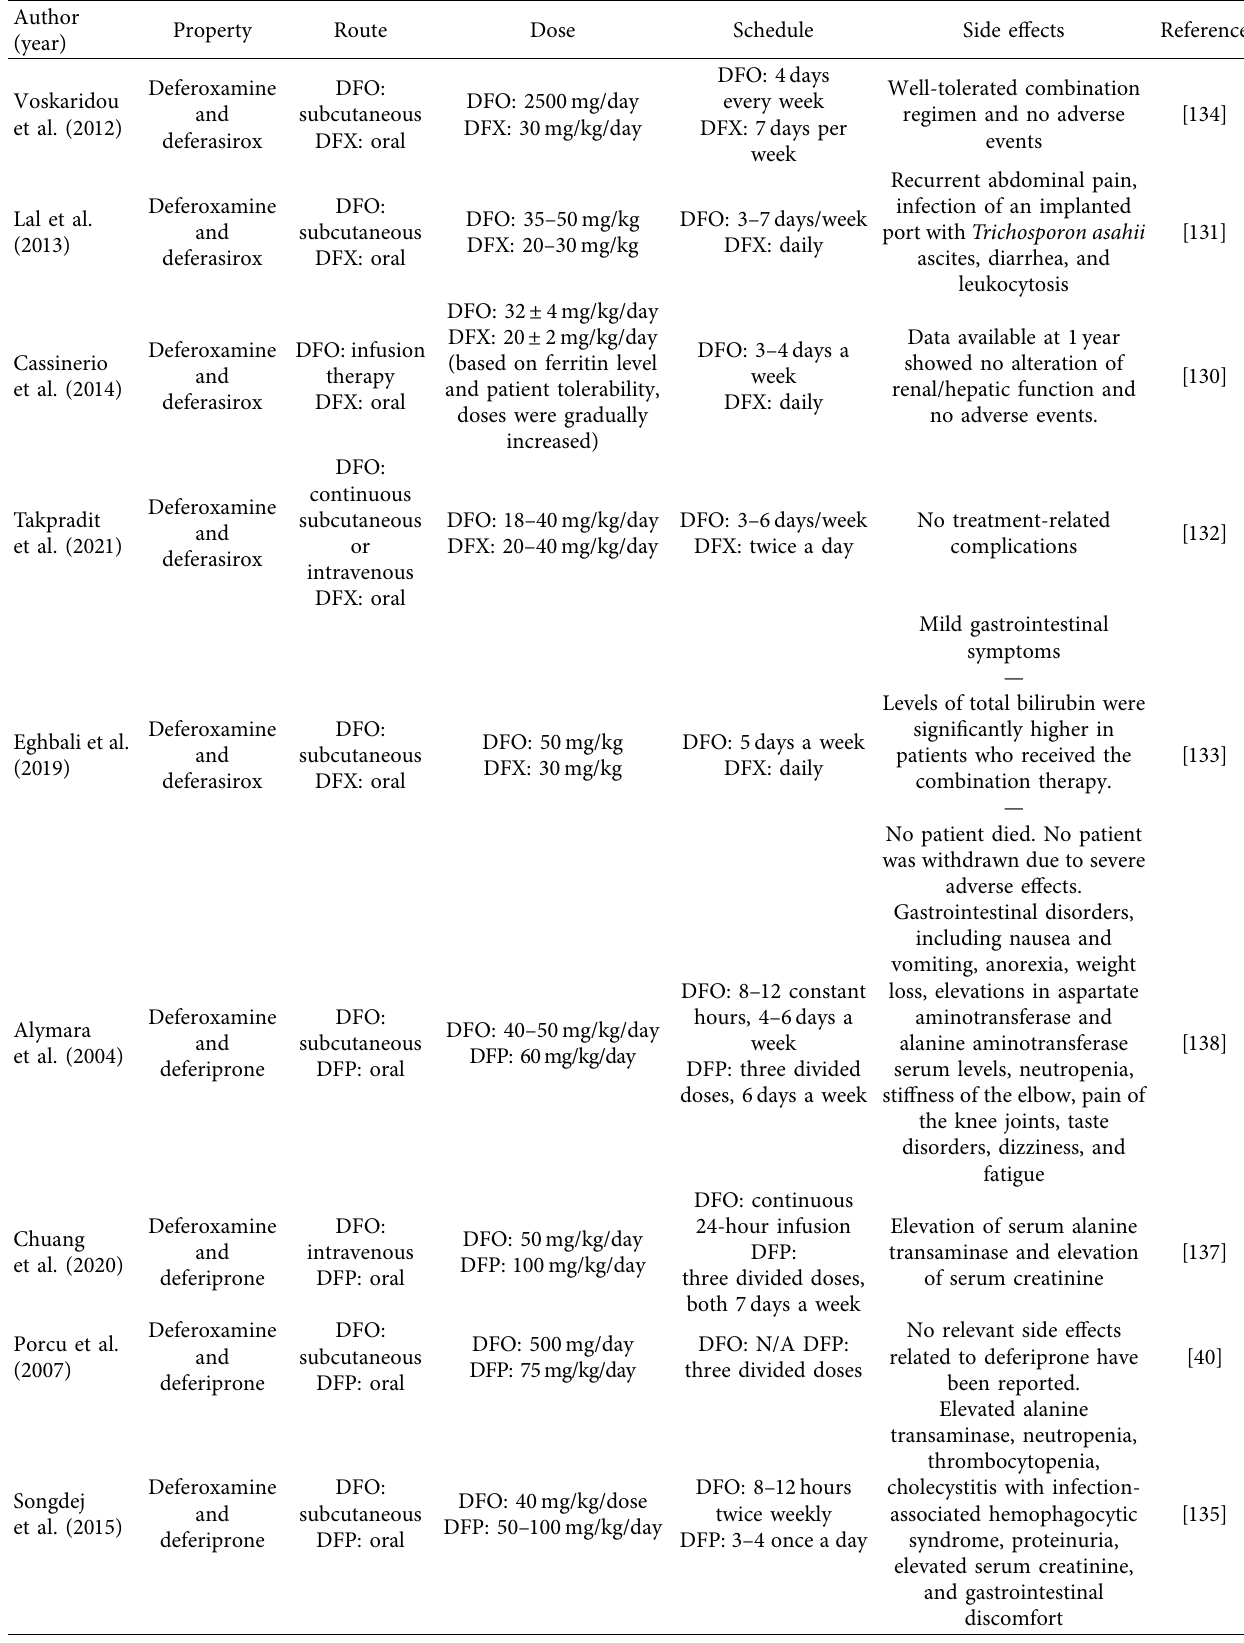
Table 4: Summary of the findings on combination